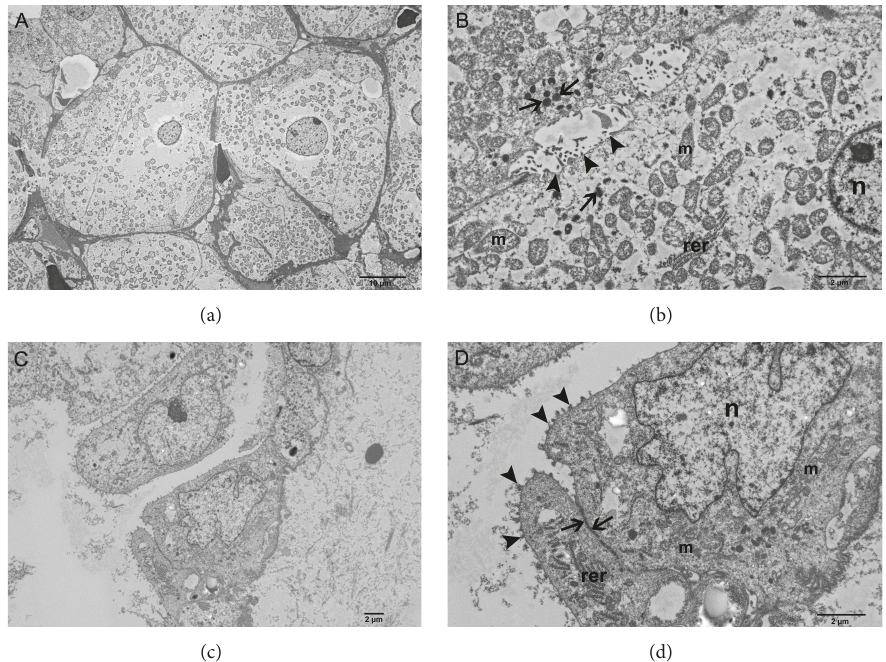
Figure 4: (a)-(d) Two different areas of tumor retrieved from the paraffin embedded sample and processed for EM: (a) Low magnification image depicting overall ultrastructural features of the peripheral tumor cells. These cells are round-ovoid and have a central nucleus, mitochondria and cytoplasmic microvesicles. (b) Higher magnification shows plasma membrane border separating two tumor cells (arrowheads), nucleus (n), abundant mitochondria (m), dense cytoplasmic vesicles (arrows), and patches of rough endoplasmic reticulum (rer). (c) Low magnification image of high grade tubulocystic tumor cells. The cells are epithelioid and have large, irregularly shaped nuclei. (d) Higher magnification shows cytoplasm with mitochondria (m), patches of rough endoplasmic reticulum (rer), irregularly shaped nucleus (n), microvillus studded apical plasma membrane (arrowheads), and junctional complex between the adjacent tumor cells